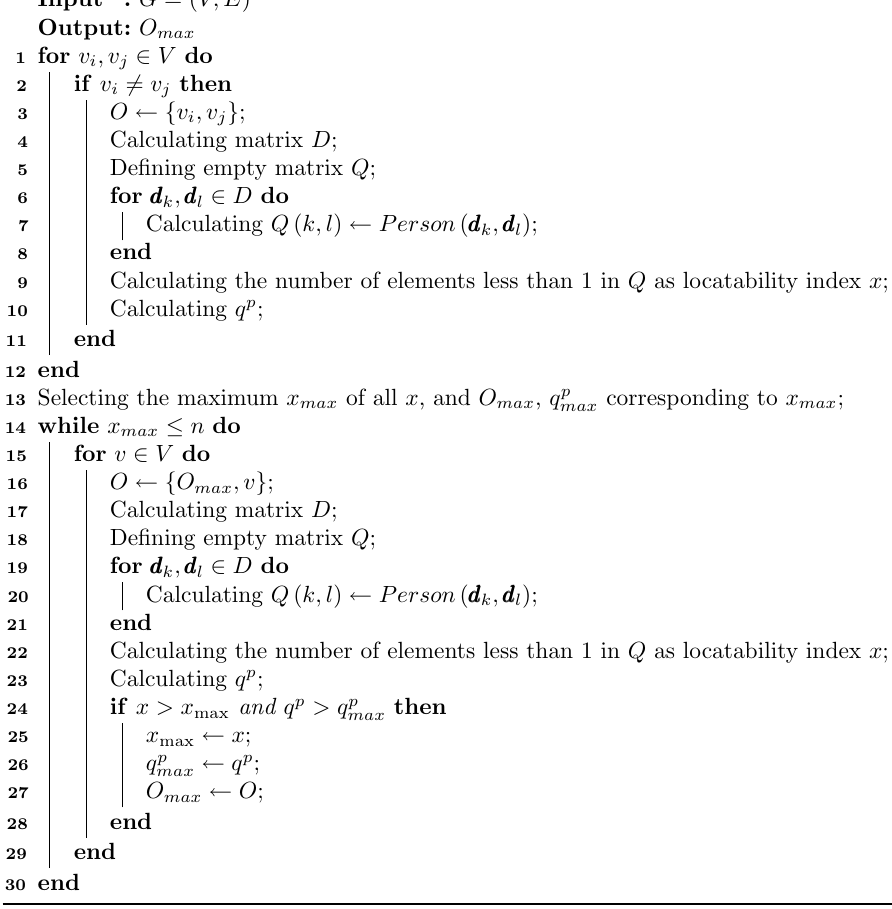
Algorithm 2: Locatability observer nodes selection